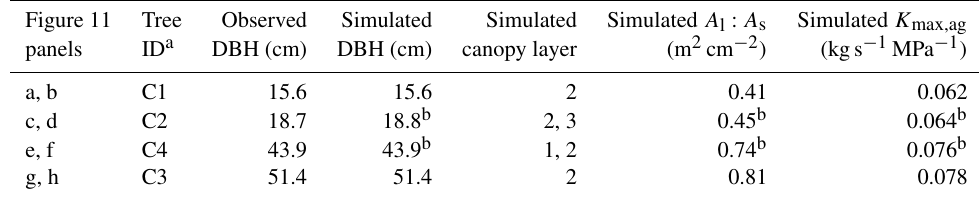
Table 3. Properties of simulated and observed trees given in Fig. 11. Figure 11 Tree Observed Simulated Simulated Simulated A l : A s Simulated K max,ag panels ID a DBH (cm) DBH (cm) canopy layer (m 2 cm − 2 ) (kgs − 1 MPa − 1 ) a, b C1 15.6